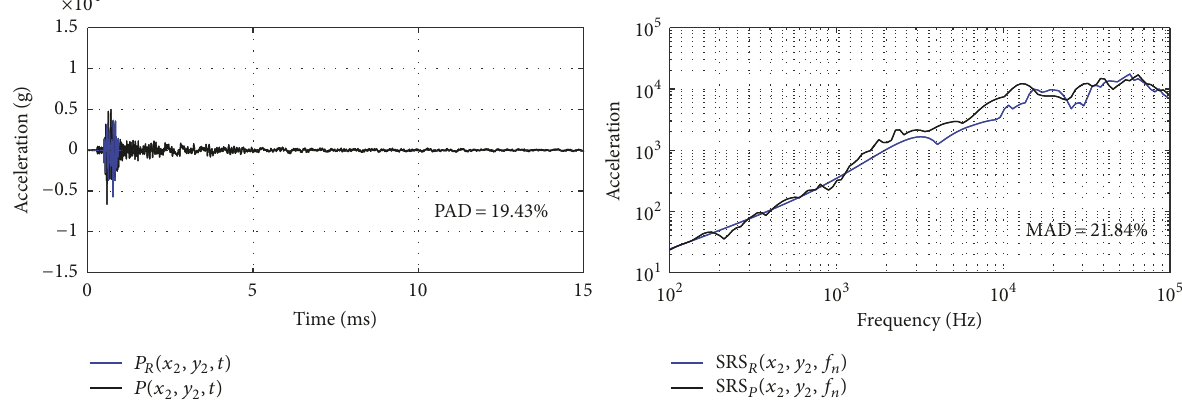
Figure 14: Time domain signal reconstruction at point 2, training point.